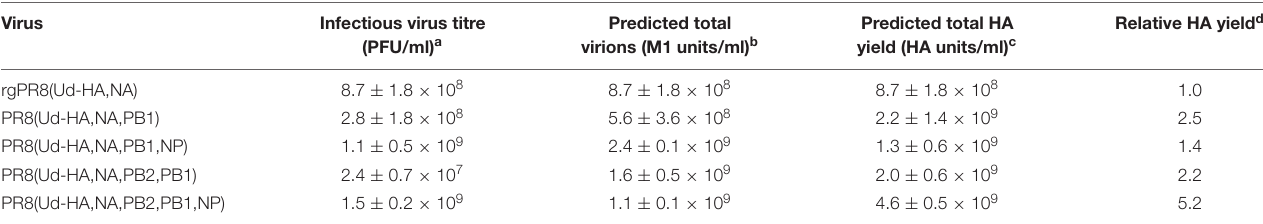
TABLE 2 | Predicted HA distribution on infectious and non-infectious